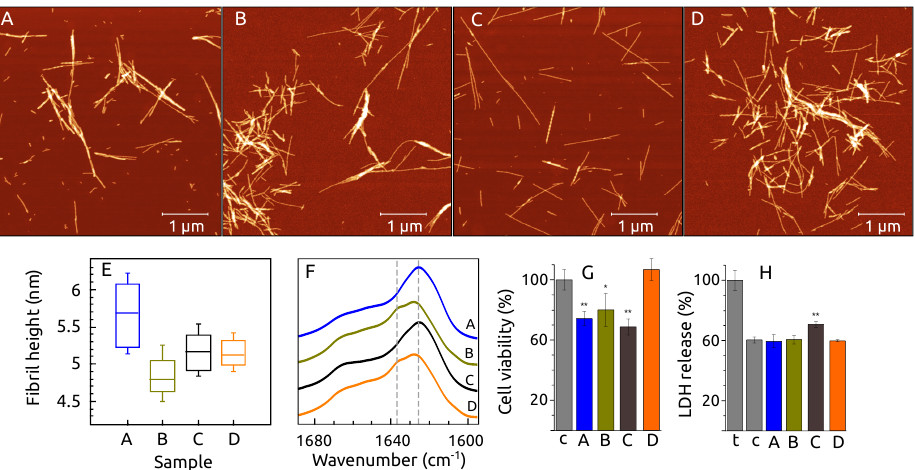
Figure 8. ( A – D ) AFM images, ( E ) fibril height, ( F ) FTIR spectra of fibril samples A – B . The influence of fibril for ( G ) SH-SY5Y cell viability and ( H ) LDH release (c—control, samples A – D , t –cells affected by detergent Triton X-100). Probabilities * p < 0.05, ** p < 0.01 show statistical significant differences between sample and control by Student’s t -test. Aggregation conditions: 100µM α -syn, 0µM or 100µM S100A9, 25mM HEPES, 100mM NaCl, 0.02% sodium azide, 50µM ThT, 1mM DTT, 0mM or 1mM CaCl 2 , pH